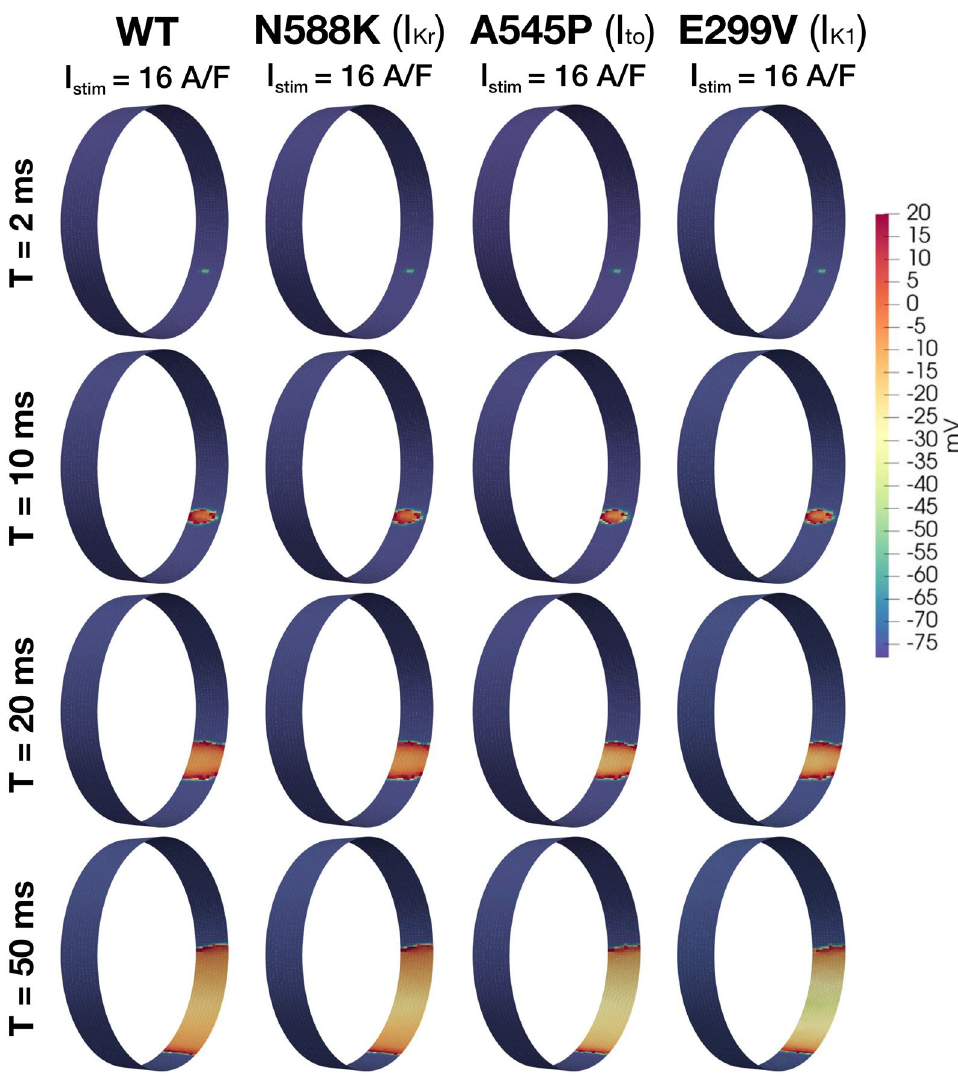
Figure 6. Excitability analysis for WT, and for the N588K, A545P, and E299V mutations. Intracellular potential of myocytes in the PV sleeve is illustrated at four different times (rows) for each mutation (columns). In all cases a regenerative AP was generated and propagated around the tissue cylinder. The stimulus intensity (applied to 2 × 2 cells for 2 ms) required to initiate the propagating action potential in each case is provided in the title for each mutation. Note that to improve the visibility, the transversal axis of the myocytes has been stretched by a factor of